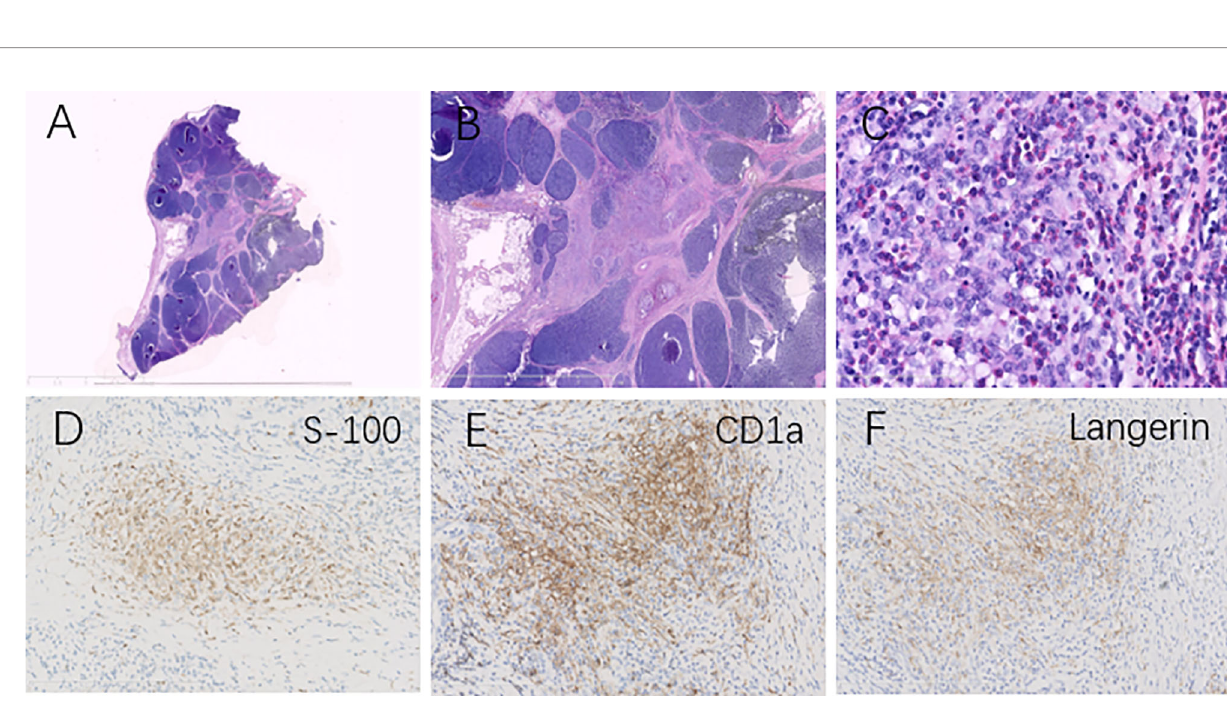
FIGURE 2 | Histopathological analysis revealed type AB thymoma composed of a lymphocyte-poor area and lymphocyte-rich area at low magni fi cation (A, B) . Clusters of mononuclear cells and eosinophils (C) were surrounded by lesions of thymoma (H&E, magni fi cation ×400), and immunohistochemical tests showed these clusters were positive for S100 (D) , CD1a (E) , and Langerin (F) , identifying the diagnosis of Langerhans cell histiocytosis in the